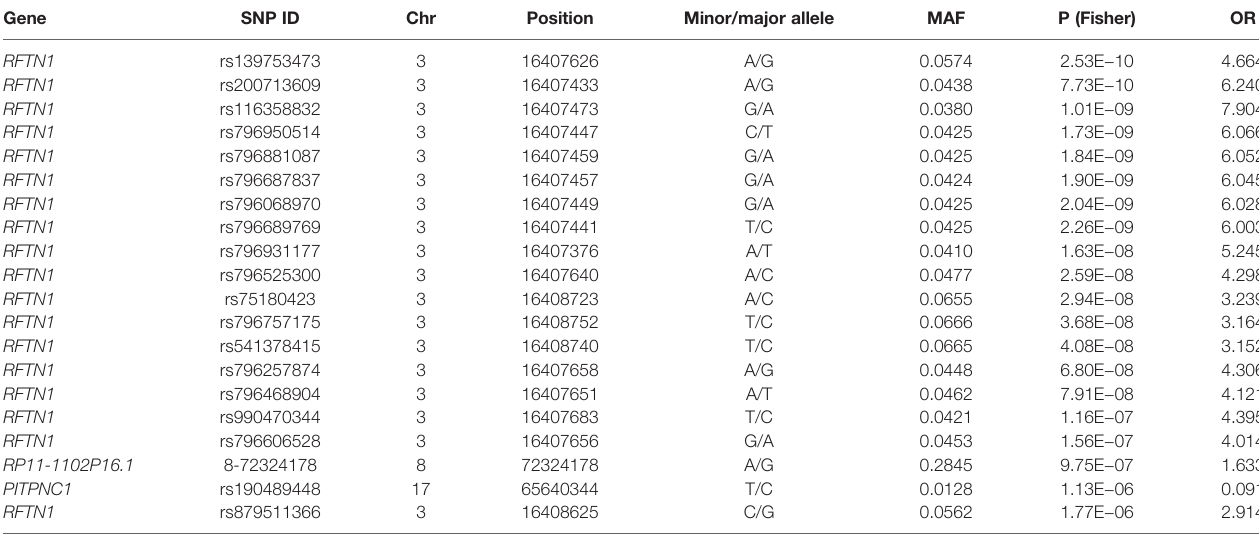
TABLE 2 | Top 20 genetic loci associated with smoking